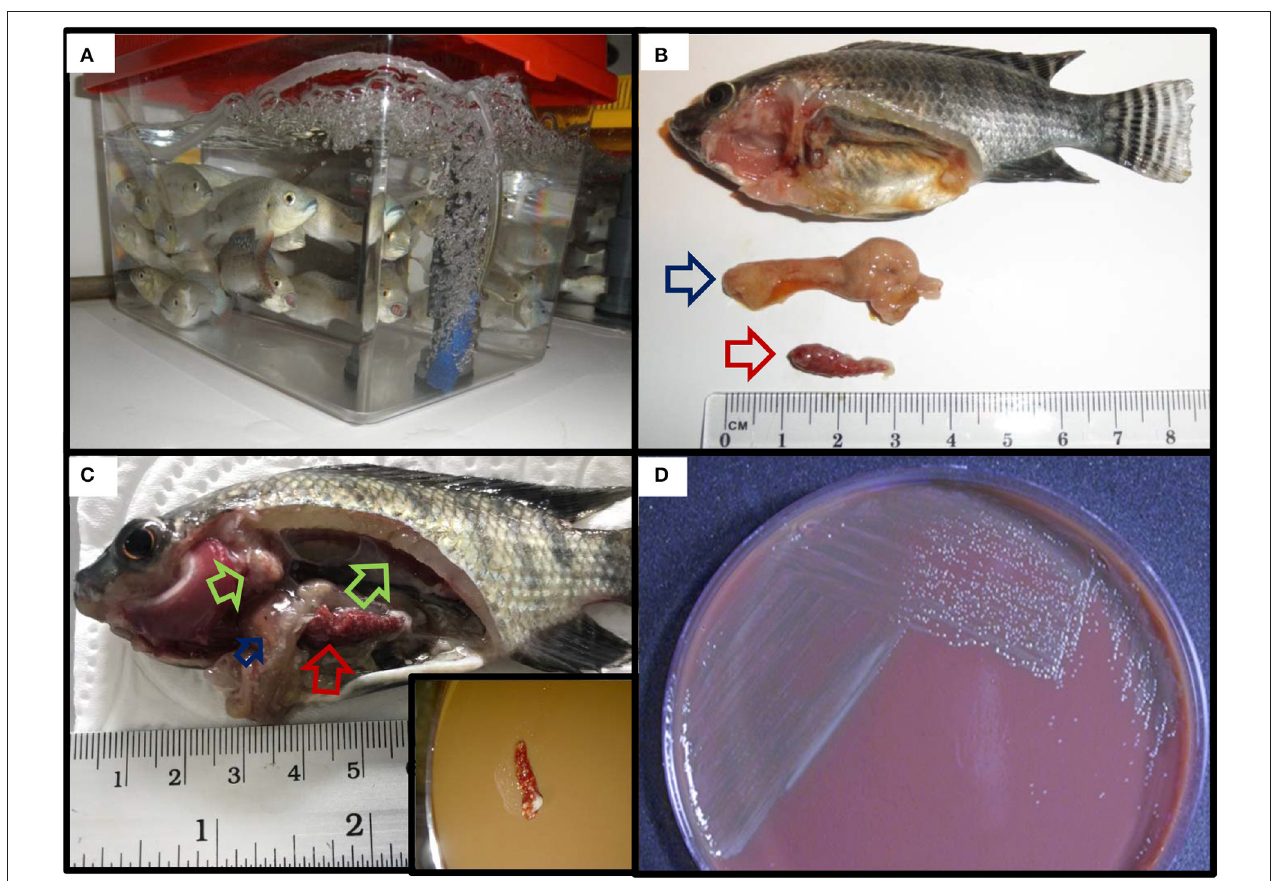
FIGURE 6 | Fulfilment of Koch’s postulates in Nile (wild type) tilapia. (A) Naïve tilapia fingerlings prior to the challenge. (B,C) Reproduction of clinical signs and gross lesions post challenge. Inset in (C) : streaking of spleen with widespread multifocal white nodules onto CHAH. (D) Recovery of pure colonies from the spleen of experimentally infected